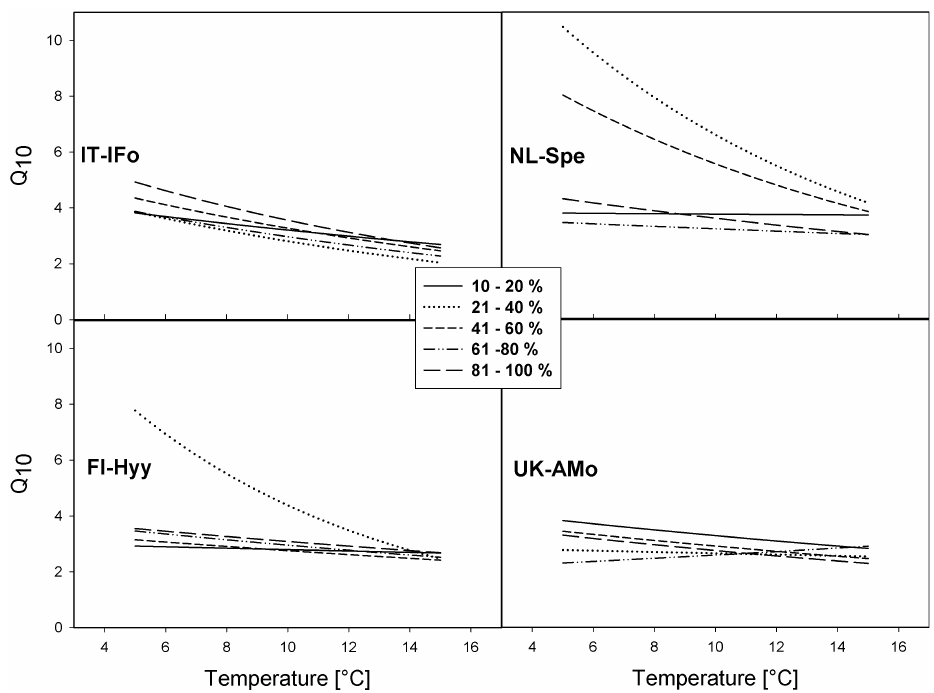
Figure 2. Calculated Q 10 values of CO 2 efflux derived from the Gaussian model as a function of temperature for each of the investigated moisture contents shown here for the deciduous forest IT-IFo, the two coniferous forests NL-Spe and FI-Hyy, and the peatland site UK-AMo.